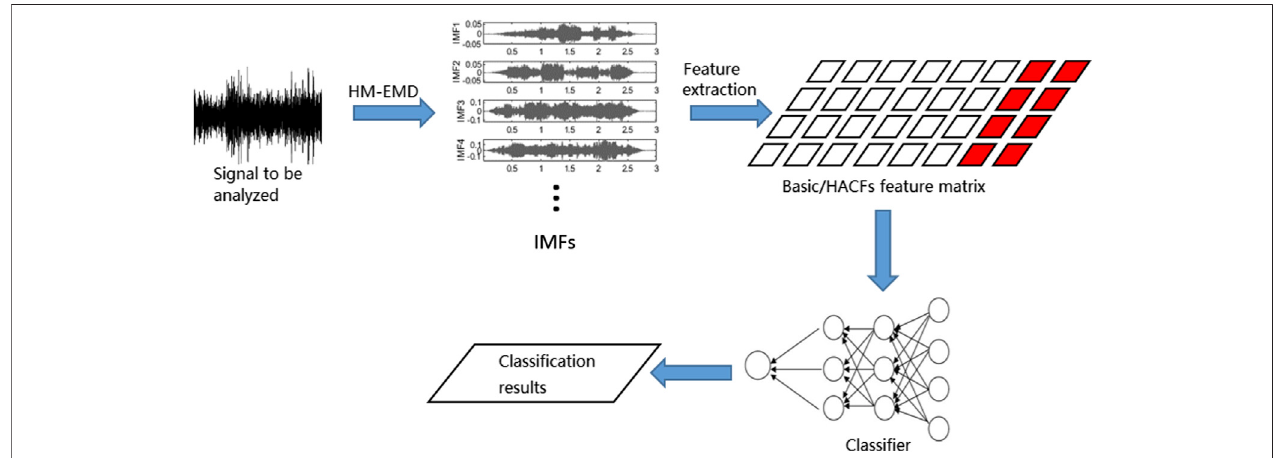
FIGURE 5 | Ambient audio stream classi fi cation fl ow chart based on heuristic mask empirical mode decomposition.